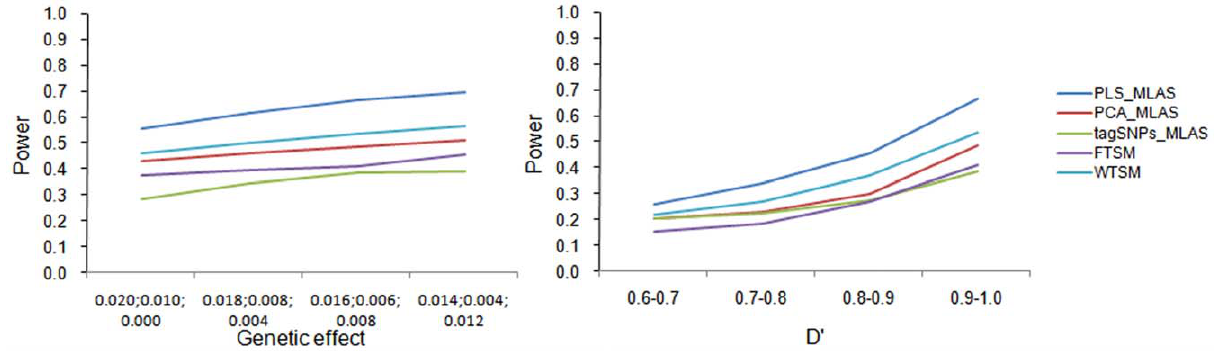
Figure 1. Power comparing results of PLS-based MLAS (PLS_MLAS), PCA-based MLAS (PCA_MLAS), tagSNPs-based MLAS (tagSNPs_MLAS), TSM-based MLAS using F test (FTSM) and TSM-based MLAS using Wald test (WTSM) under the epistatic